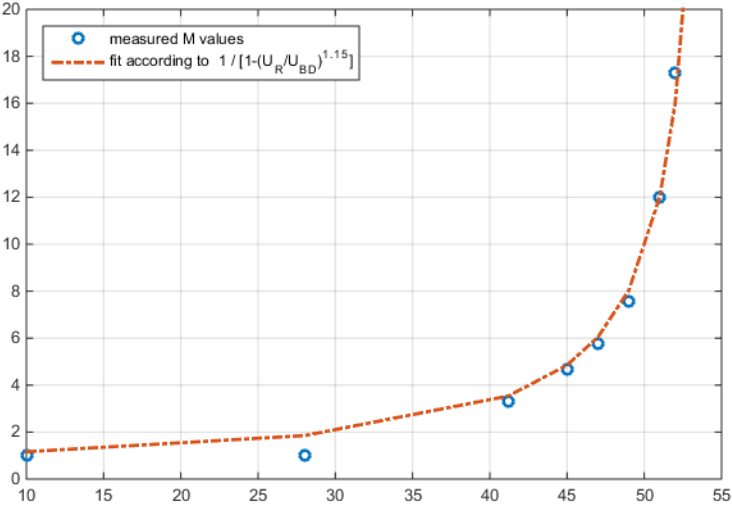
Figure 4. Measured and calculated M , according to (8), over the reverse voltage U R for U BD = 55 V and n = 1.15.